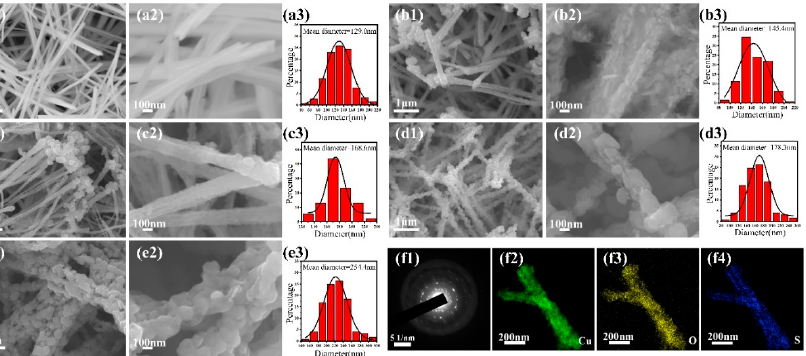
Figure 2. SEM images and size distributions of ( a1 – a3 ) CC-0, ( b1 – b3 ) CCC-1, ( c1 – c3 ) CCC-2, ( d1